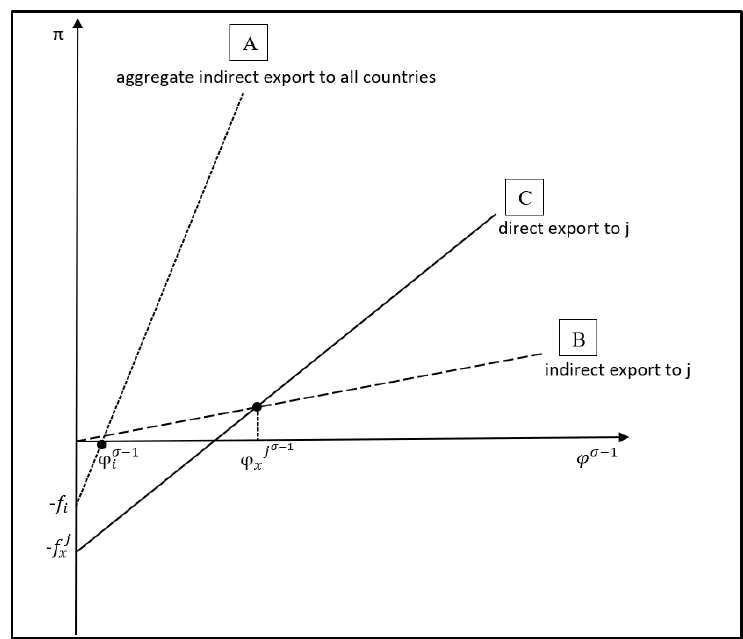
Figure 1: AKW’s model of intermediary